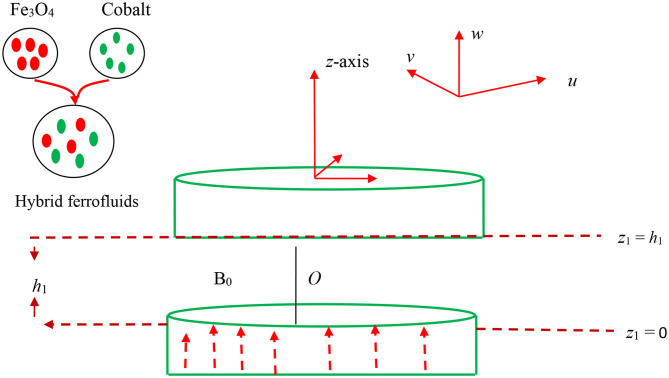
Physical diagram of the problem.